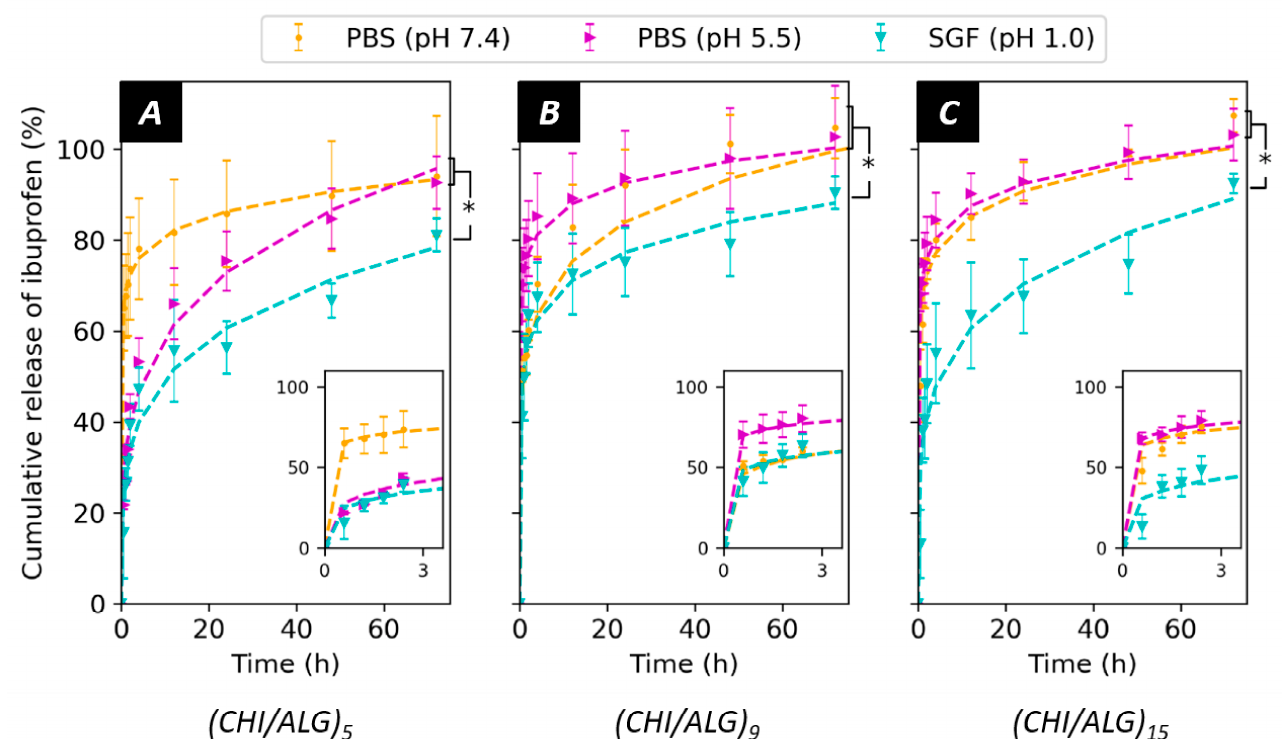
Figure 7. Drug release in PBS (pH 7.4), PBS adjusted to pH 5.5 and SGF (pH 1) from ( A ) (CHI/ALG) 5 , ( B ) (CHI/ALG) 9 , and ( C ) (CHI/ALG) 15 . The release rates were fitted using the Ritger–Peppas (power law) model. Statistical significance is indicated with * when comparing the release PBS (pH 7.4) and PBS (pH 5.0) with the release in SGF(pH 1.0).